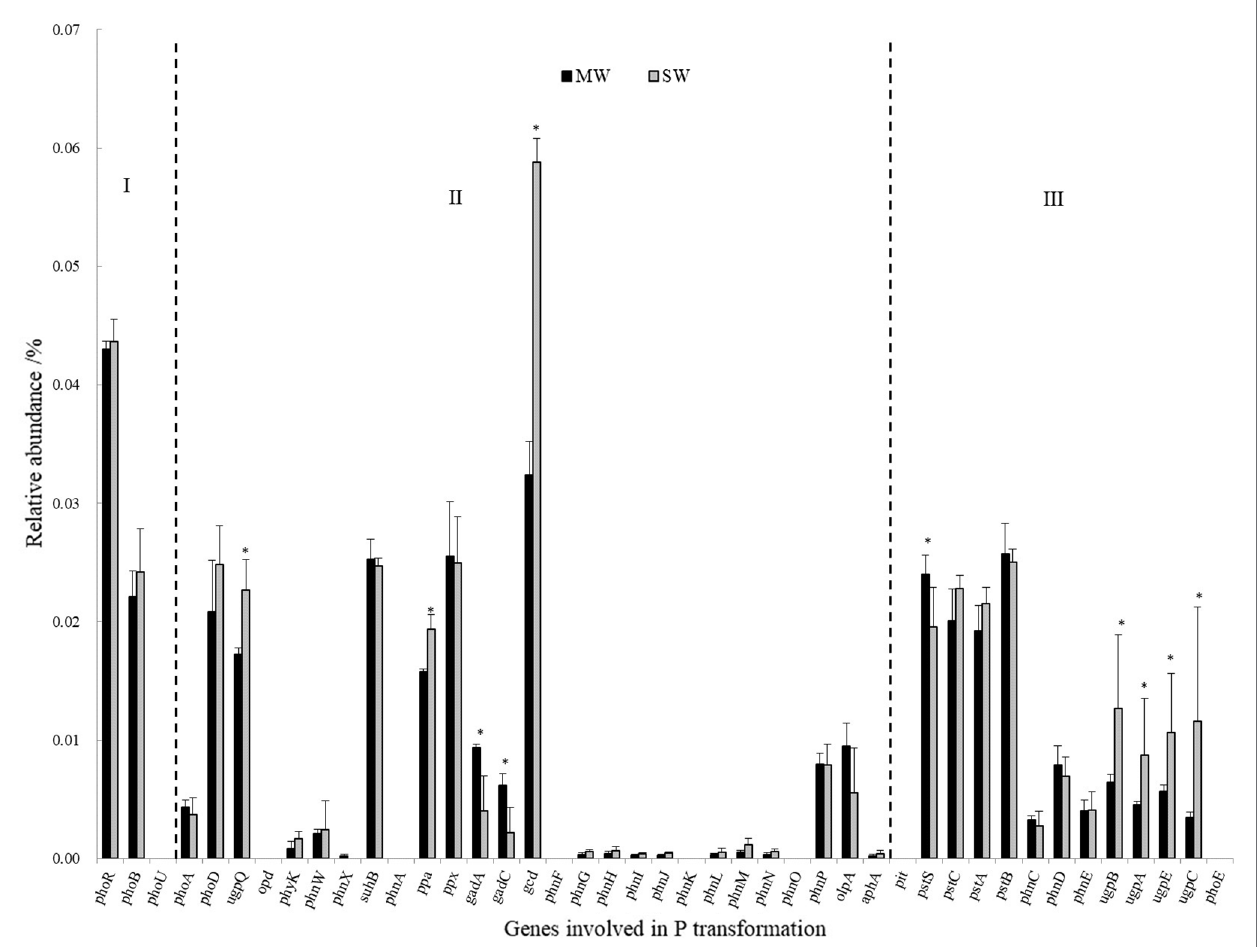
FIGURE 8 | The relative abundances of genes involved in P transformation between SW and MW rotations. SW, soybean-wheat rotations; MW, maize-wheat rotations; I, Genes coding for P-starvation response regulation; II, Genes coding for inorganic P-solubilization and organic P-mineralization; III, Genes coding for P-uptake and transport. Asterisk represents the significant differences in the relative abundance of genes involved in P transformation at p < 0.05 between MW and SW